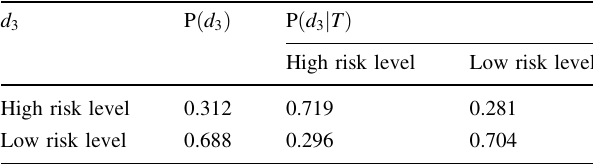
Fig. 6 Convergence curve of the solution of the objective function Table 10 Optimal conditional probability table at high and low risk levels